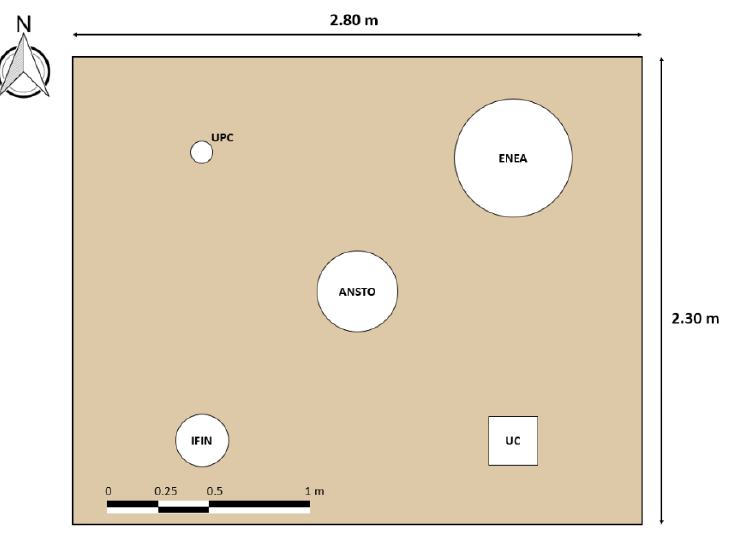
Figure 1. Position setup of the radon flux systems in the field. The shapes, positions, and dimensions are to scale.